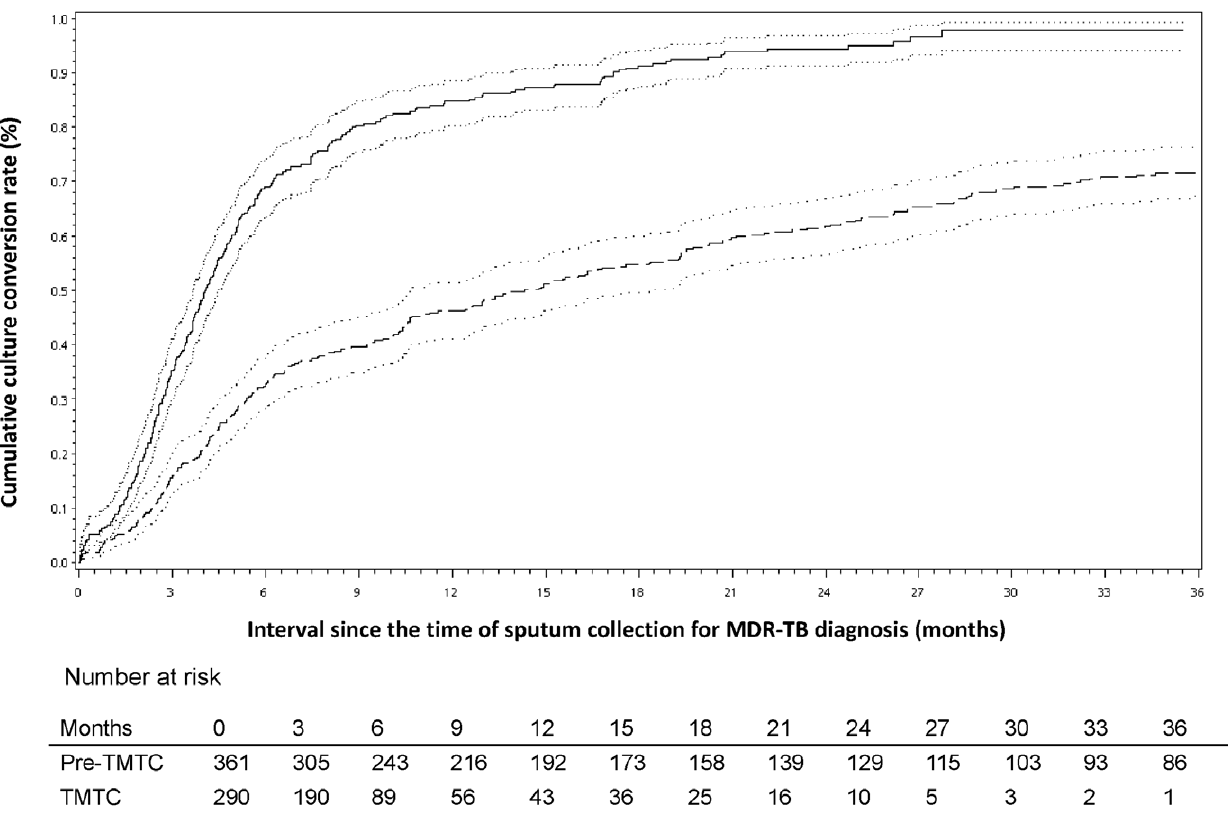
Figure 2. A comparison of the cumulative sputum conversion rates of multidrug-resistant tuberculosis (MDR-TB) cases in the pre- Taiwan MDR-TB Consortium (TMTC) era and the TMTC era. Dashed line, pre-TMTC era; solid line, TMTC era; dotted line, 95% confidence interval (p , 0.001 by the log-rank test).